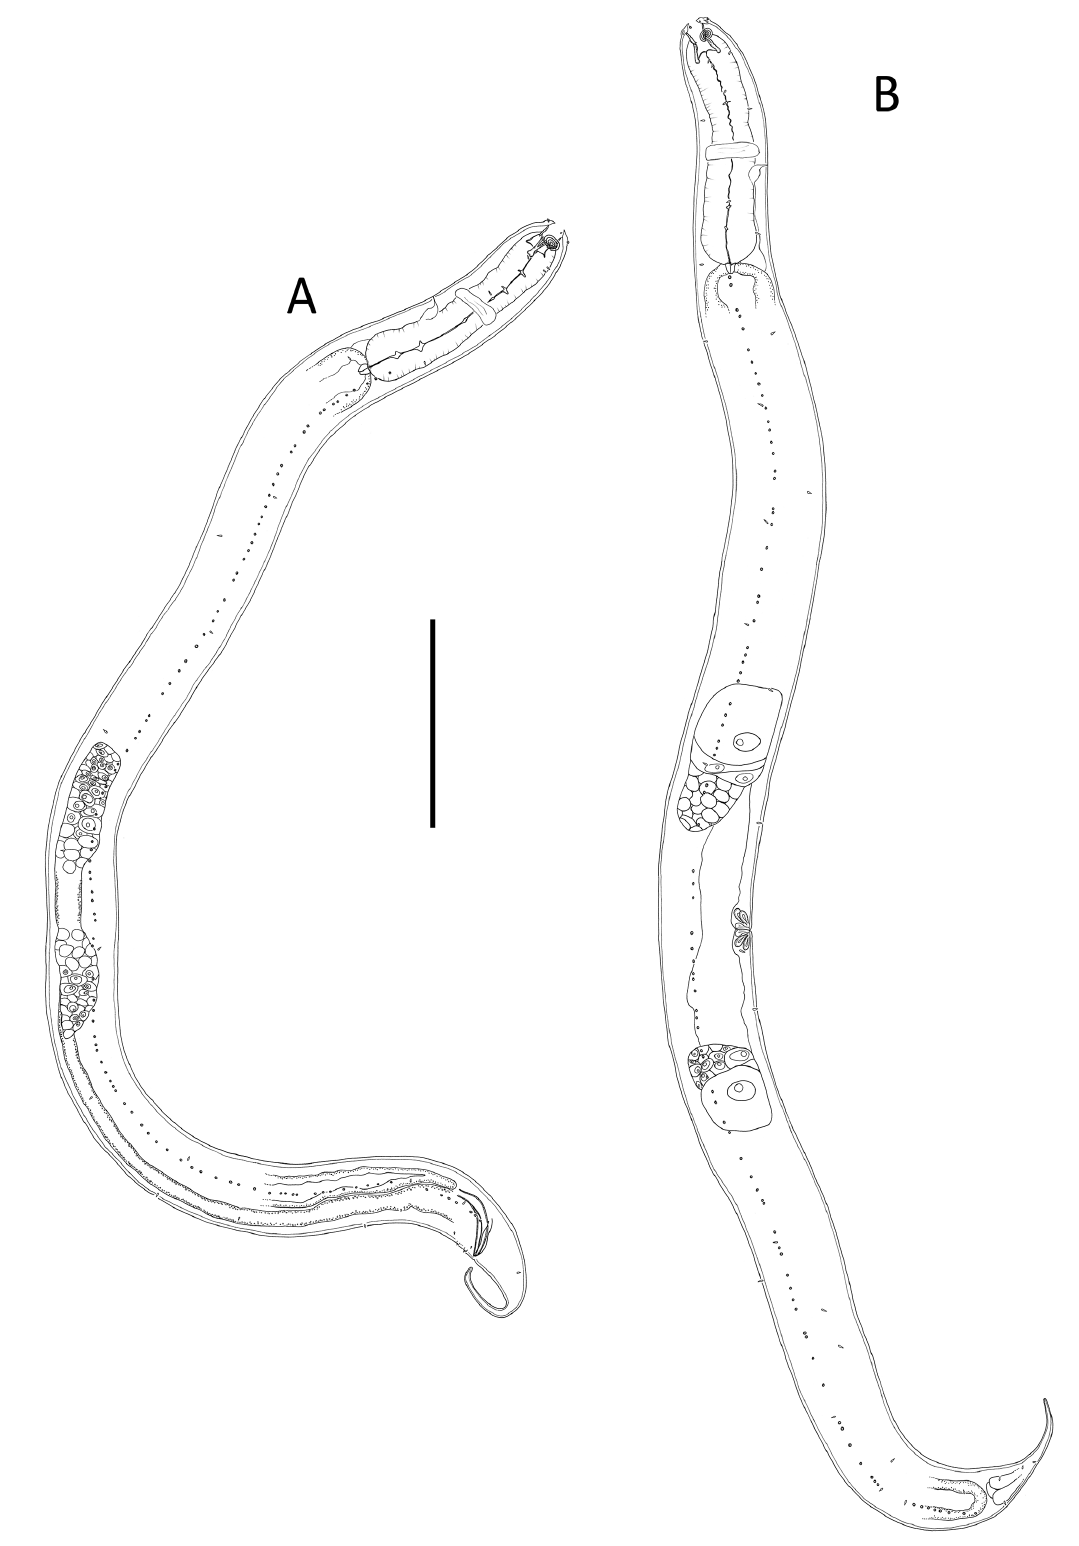
Fig. 5. Halichoanolaimus ossilagulus sp. nov. A . Entire holotype ♂ (NIWA 139246). B . Entire paratype ♀ (NIWA 139247). Scale bar = 150